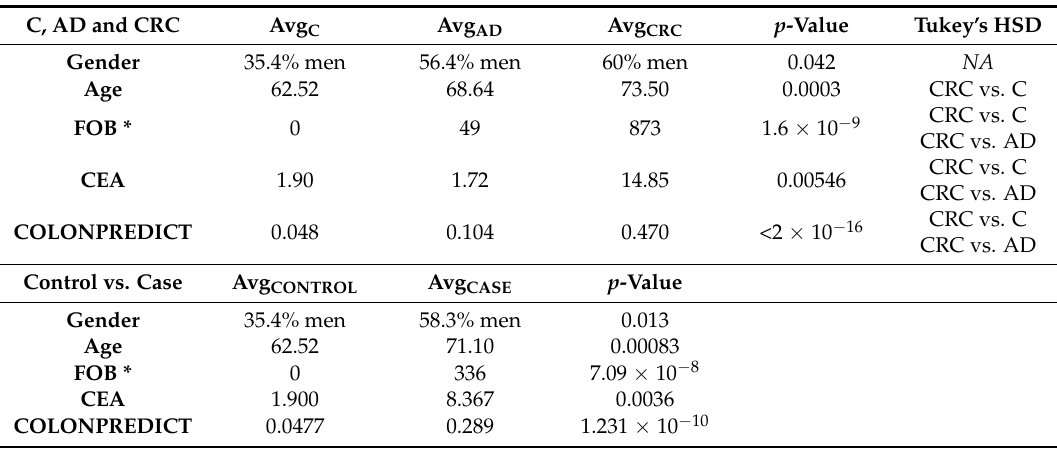
Table 2. Differences between sample classification of several clinical parameters, either for the groups comparison (C, AD and CRC) and for the pairwise comparison (Control vs. Case). ANOVA test has been used for the study of differences between the three groups classification (C, AD and CRC) and Tukey’s HSD test was used to analyse pairwise classifications (C vs. AD, C vs. CRC and AD vs. CRC). Tukey’s HSD column depicts those pairwise combinations (of the three tested combinations) that showed to be significantly different. Avg. stands for